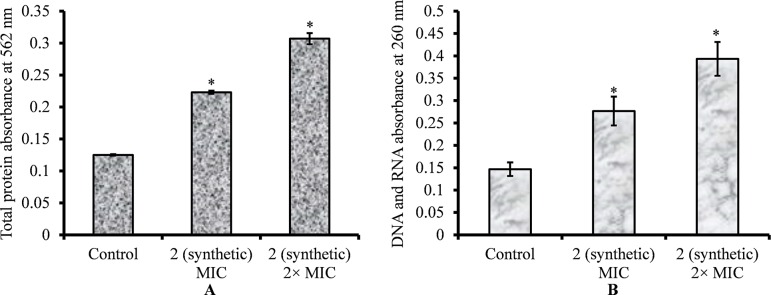
Quantification of total protein and genetic material (DNA and RNA) released by S. pneumoniae D39 on viniferin treatment. (A) Quantification of total protein released by pneumococci on viniferin treatment (MIC or 2 × MIC), detected by Pierce BCA protein assay. The results are expressed as the absorbance of total proteins at 562 nm. (B) Measurement of total DNA and DNA in cell-free supernatant, assessed by detecting absorbance at 260 nm. Error bars represent standard deviations. Statistical significance was calculated using Student’s t-test, and p < 0.05 was considered significant.